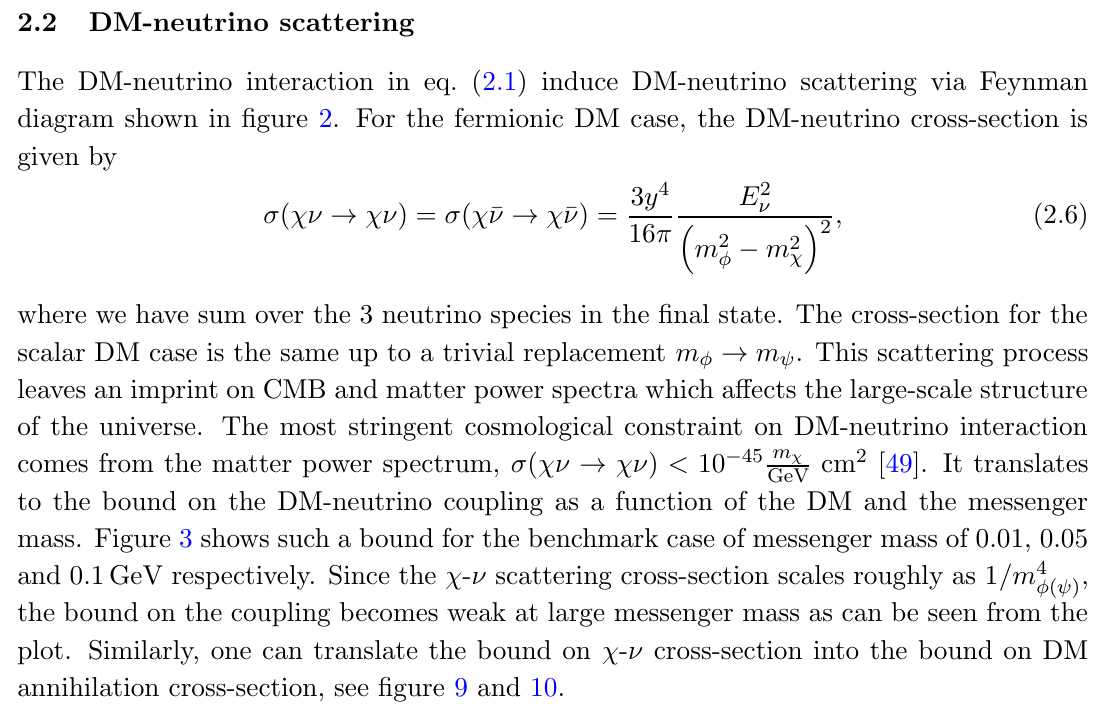
Figure 2. The diagrams contribute to (cid:31) and the scalar DM case